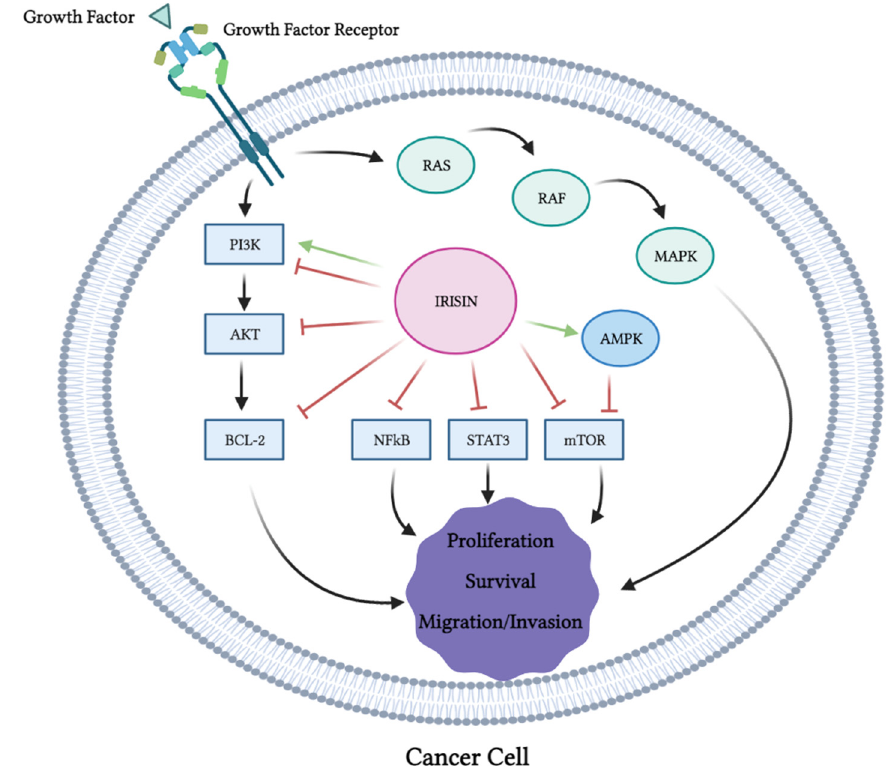
Figure 3. Effects of irisin on cancer cell signaling molecules. PI3K, Akt, Bcl-2, NF- κ B, STAT3 and mTOR were all inhibited by irisin. Irisin activated AMPK and MAPK. This figure is based on the data of the studies mentioned in the in vitro section and Table 1. The figure was created with Bio ‐ Render.com.